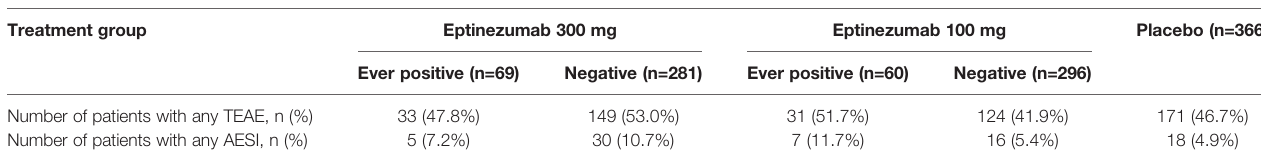
TABLE 8 | Summary of TEAEs and AESI by anti-eptinezumab antibody (ADA) status for PROMISE-2. Treatment